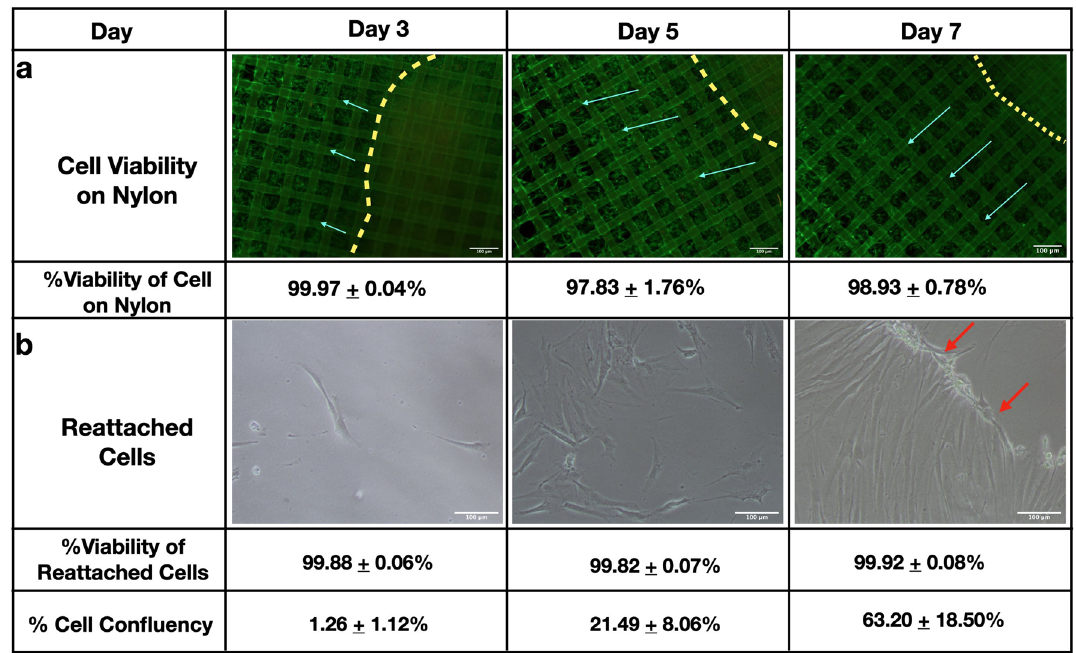
Figure 2. Viability of fibroblast cell sheets on nylon dressing and cell reattachment. ( a ) Fluorescence images of LIVE/DEAD-stained fibroblast cells on nylon dressing at days 3, 5 and 7 and their cell viability percentages are presented. Note that the green fluorescence represents live cells, while red fluorescence indicates dead cells. ( b ) The phase-contrast images show the morphology of the fibroblasts relocated to a new culture dish surface at various time points. The confluency and viability percentages of the reattached fibroblast cells were calculated and are shown in this figure. The yellow dotted line represents the edge of the fibroblast cell sheet, and the light blue arrows indicate the outgrowth cell direction on the nylon dressing. The red arrows show the area where the cell grew out from the edge of the sheet. The results are displayed as the mean ± SD (n = 6). The scale bars represent 100 μm.